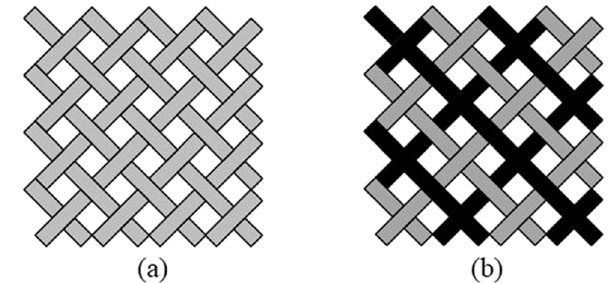
Figure 2: Two yarn arrangements: ( a ) pure glass fi ber and ( b ) carbon fi ber/glass fi ber ratio = 1:1. ( Black is carbon fi ber yarn and gray is glass fi ber yarn ) .